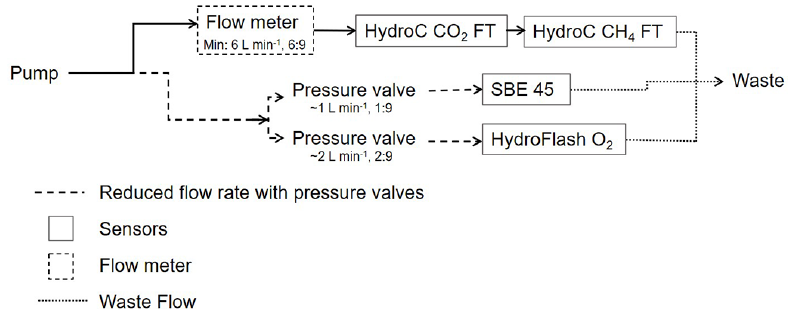
Figure 1. Flow schematic of the set-up, including minimal flow ratios. The flow rate was measured only for the main flow. For the side flows, the rate was adjusted, by pressure valves, to be a fraction (i.e. 1 : 9 and 2 : 9 for Lmin − 1 ) of the total flow. Table 1. Sensors and their manufacturer specifications, along with calibration range (for the CONTROS HydroC ® CO 2 FT and CH 4 FT, factory calibration ranges were specific to the